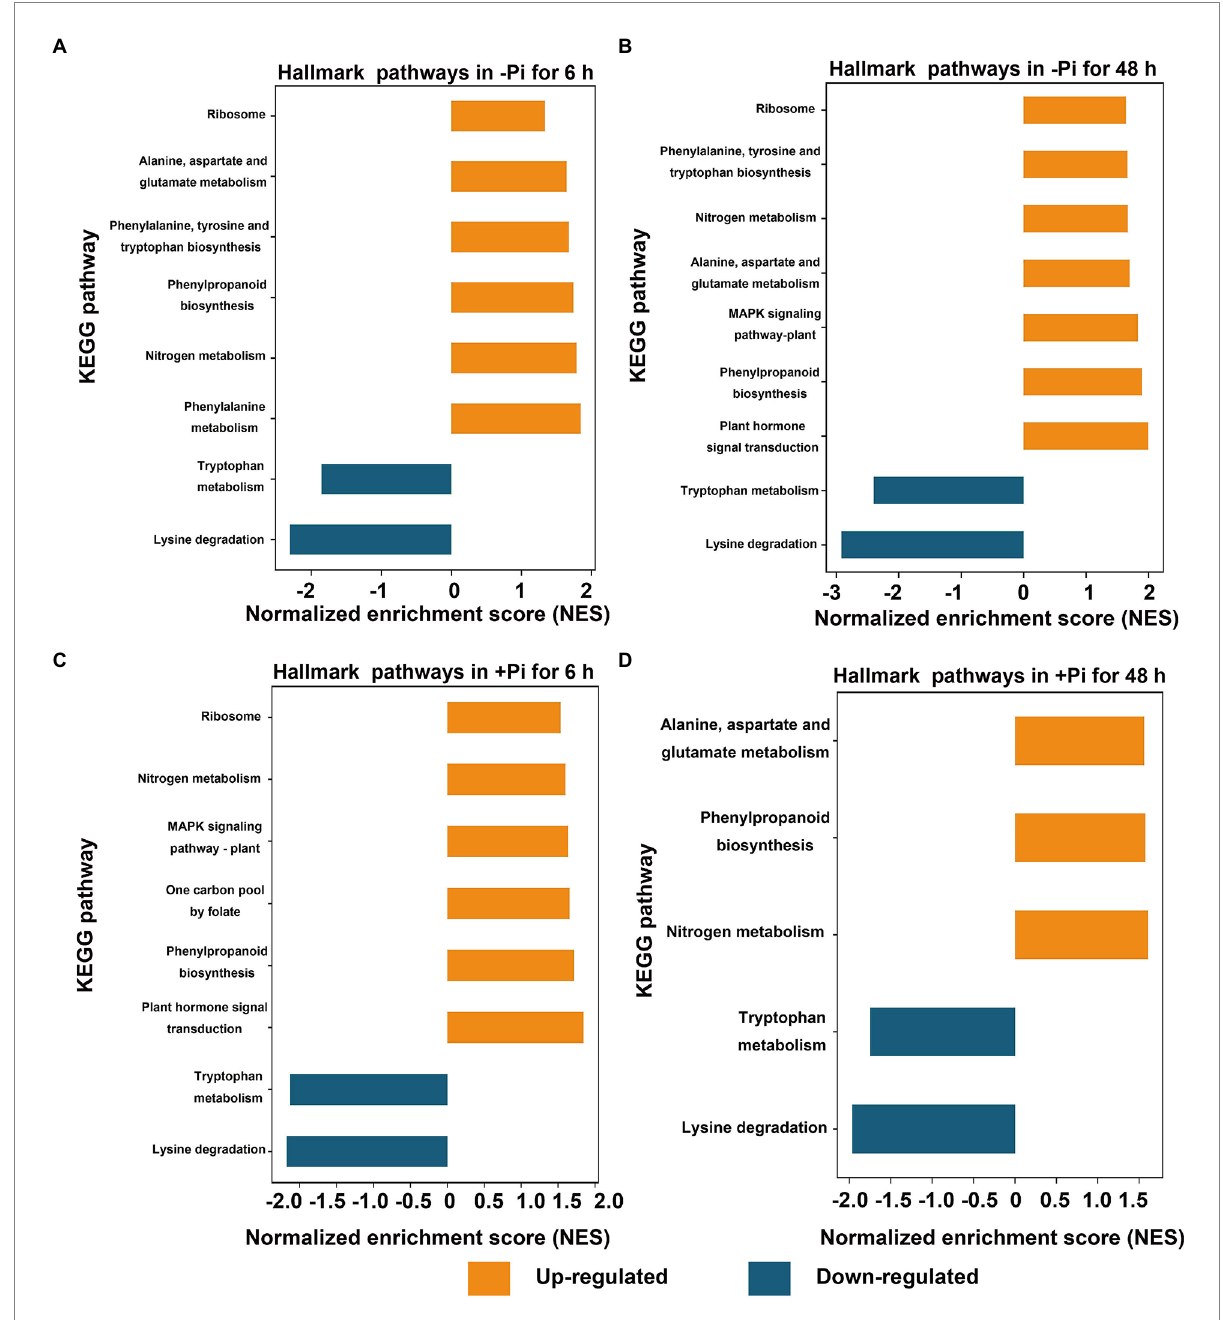
FIGURE 4 GSEA of significantly up- (FDR < 0.1, NES > 1.5; orange) or down- (FDR < 0.1, NES < –1.5; blue) regulated metabolic pathways in response to Pi starvation (–Pi) for 6 h (A) and 48 h (B) , and Pi recovery (+Pi) for 6 h (C) and 48 h (D) with regard to succinylated proteins, respectively. Gene sets with an FDR < 0.01 are displayed using bar plots. FDR, false discovery rate; GSEA, Gene Set Enrichment Analysis; NES, normalized enrichment score; Pi, intracellular phosphate.